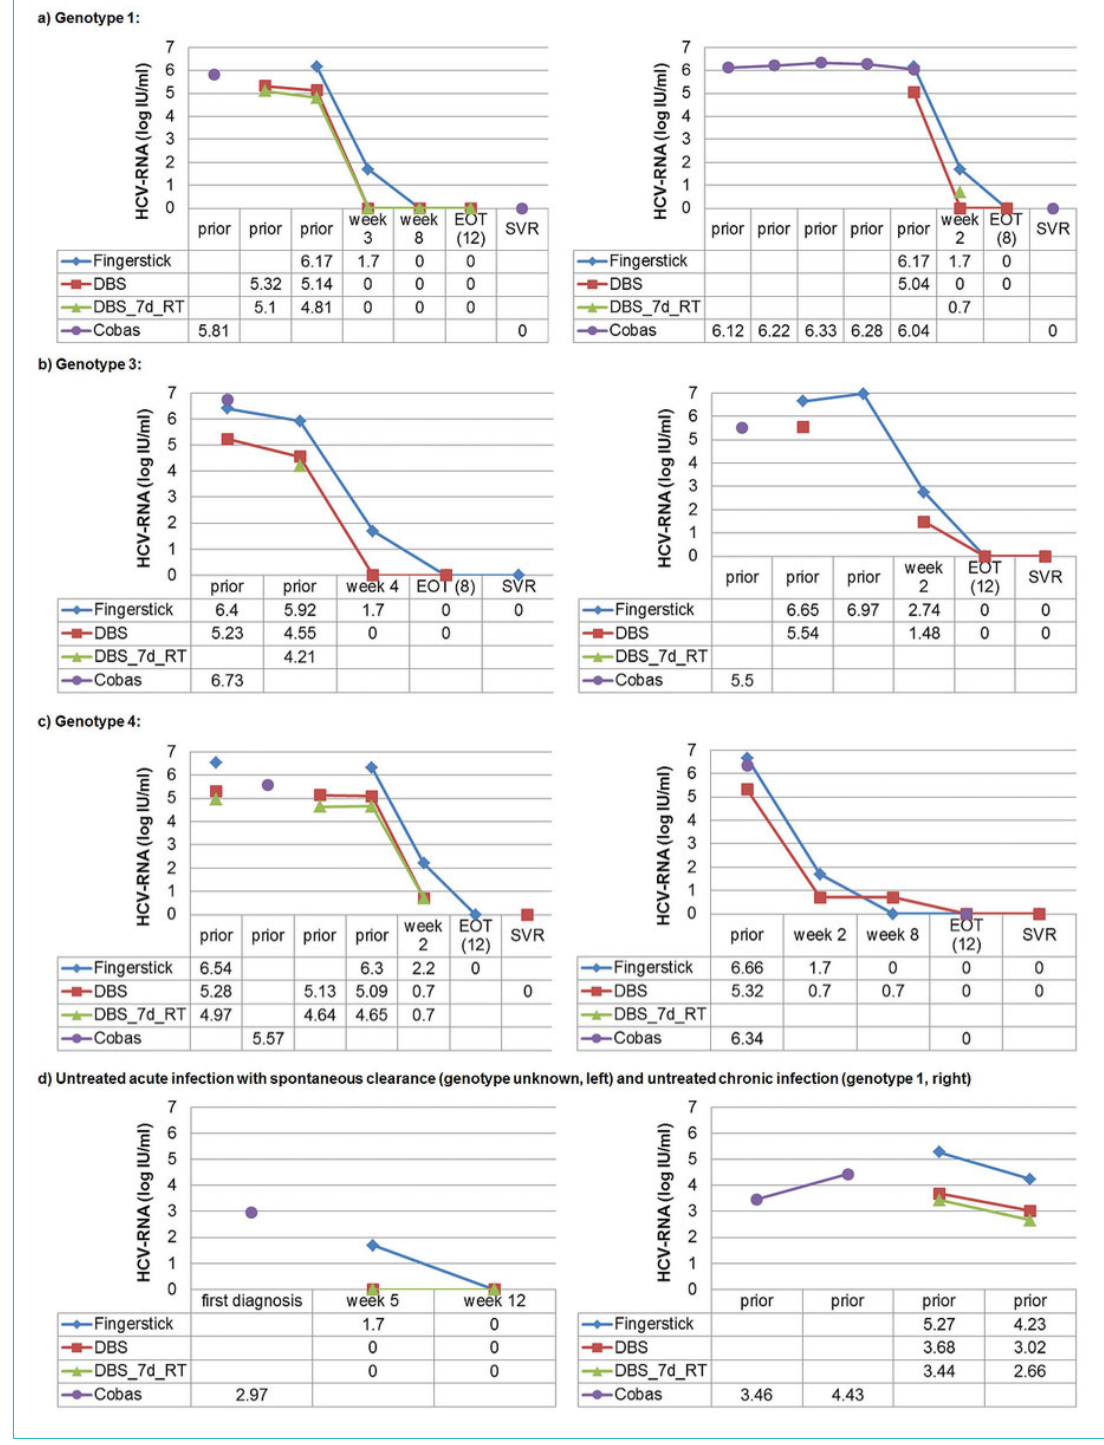
Figure 2: HCV RNA course in eight exemplary patients with different genotypes: prior to, during and after direct-acting antiviral (DAA) treat- ment as well as during untreated acute and chronic infection. Fingerstick = Xpert ® HCV Viral Load Fingerstick-test (limit of quantification 100 IU/ml, 2.0 log IU/ml); DBS = Xpert ® HCV Viral Load test (limit of quantification 10 IU/ml, 1.0 log IU/ml) in DBS samples produced with 100 µl capillary whole-blood and stored at –20°C within 48 hours after capillary blood draw (uncorrected result); DBS_7d-RT = Xpert ® HCV Viral Load test in DBS samples produced with 100 µl capillary whole blood and exposed to room temperature for 7 days prior to storage at –20°C (uncorrected result); Cobas = Cobas ® assay with 650 µl venous plasma (limit of quantification 15 IU/ml, 1.2 log IU/ml); prior = prior to HCV treatment; week 2, week 3, week 4, week 8 = respective weeks under HCV treatment; EOT (8) = end of treatment (week 8); EOT (12) = end of treatment (week 12); SVR = sustained virological response; 0 = HCV RNA not detectable; first diagnosis = first diagnosis of acute he- patitis C; week 5, week 12 = respective week after diagnosis of acute hepatitis C. For unquantifiable positive Xpert ® HCV Viral Load Finger- stick test results (i.e., “detectable below the limit of quantification of 100 IU/ml, 2.0 log IU/ml”), the mid-point between zero and the lower limit of quantification was used (i.e., 50 IU/ml, 1.70 log IU/ml). For unquantifiable positive Xpert ® HCV Viral Load test results (i.e., “detectable below the limit of quantification of 10 IU/ml, 1.0 log IU/ml”), the mid-point between zero and the lower limit of quantification was used (i.e., 5 IU/ml, 0.70 log